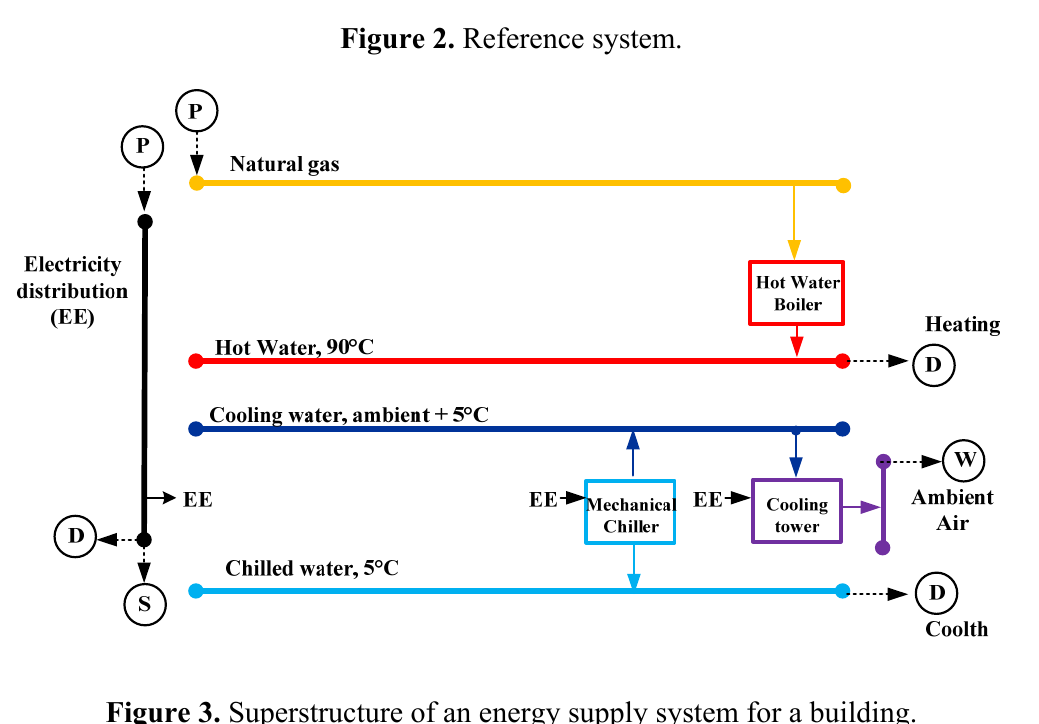
Figure 3. Superstructure of an energy supply system for a